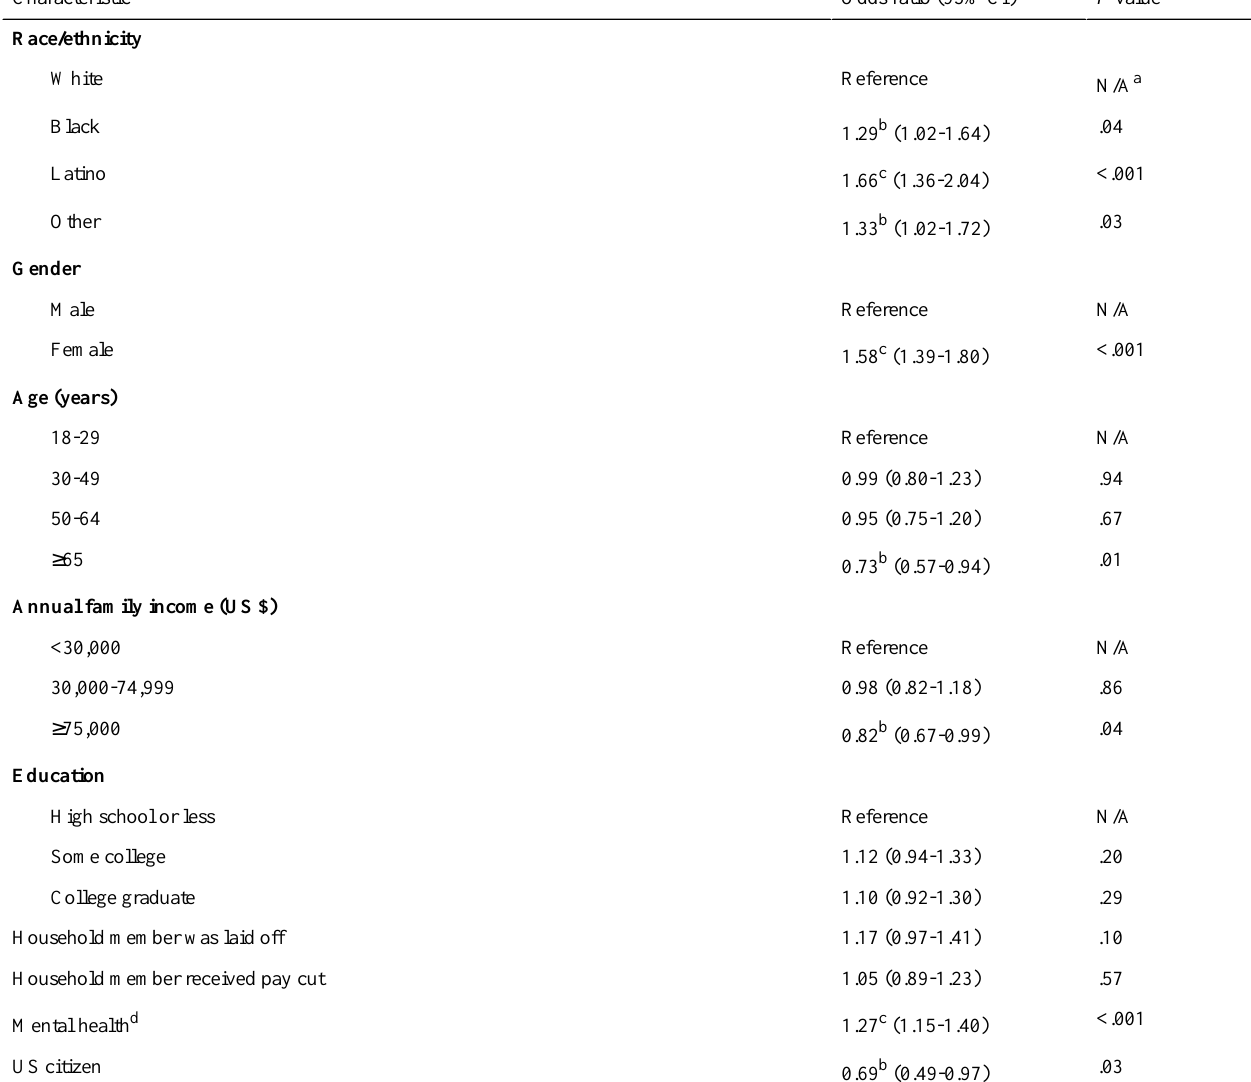
Table 2. Associations between respondent characteristics and reported posting on social media about the COVID-19